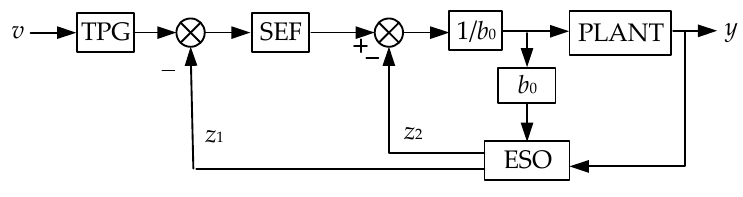
Figure 5. General structure of ADRC.